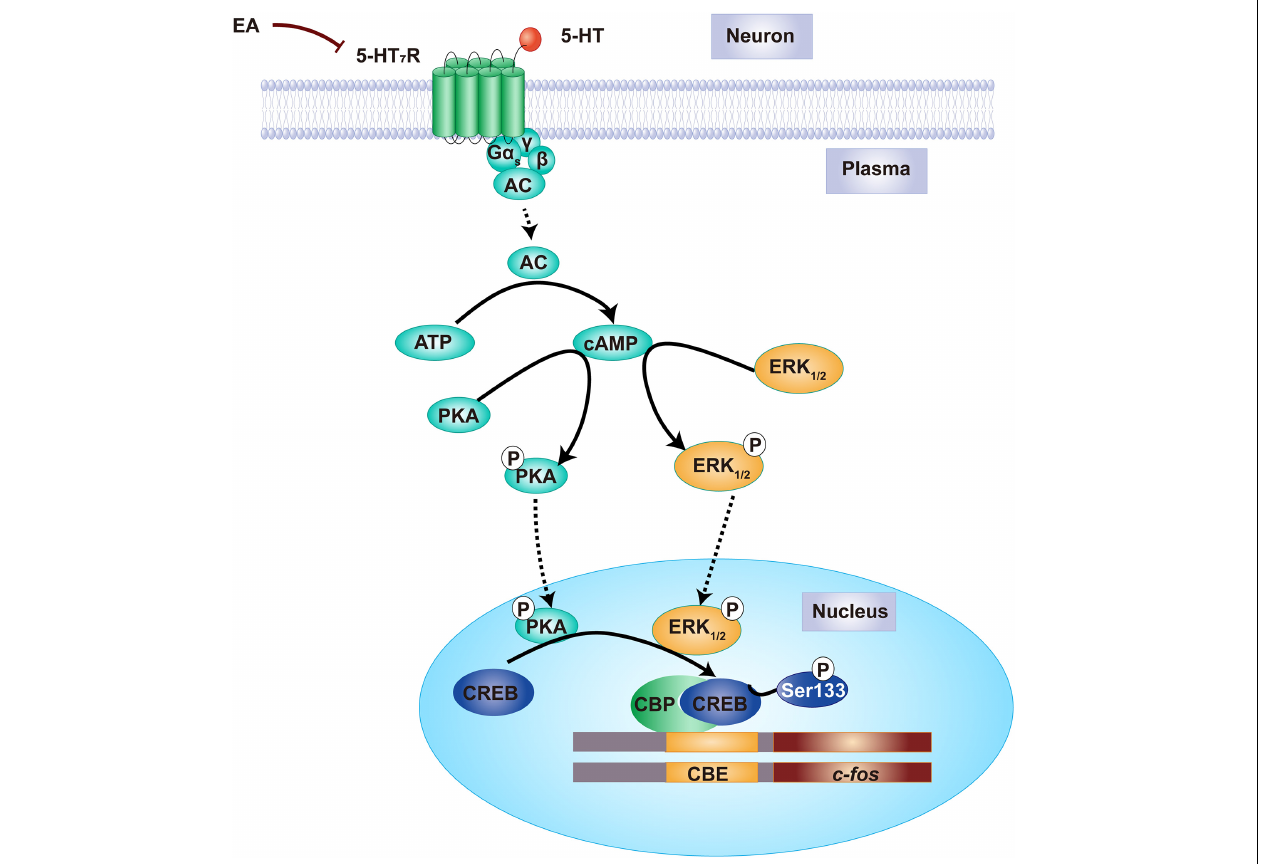
FIGURE 10 | Proposed mechanism of the antihyperalgesic effects of EA stimulation. Before EA, there is a relatively high amount of 5-HT 7 R protein in TG and TNC of IS rats. The medial cAMP is formulated in the cytoplasm of neuron, resulting in PKA and ERK 1 / 2 phosphorylation. Once PKA and ERK 1 / 2 are phosphorylated into p-PKA and p-ERK 1 / 2 , the CREB will move from the cytoplasm into the nuclear and phosphorylated at Ser133. Following nuclear CREB-CBP elevation, the initiate or potentiate of early gene c-fos was regulated by p-CREB-mediated transcription, resulting in dural IS stimulation that leads to hyperalgesia. By contrast, EA treatment decreases the amount of 5-HT 7 R proteins, forming lower cAMP, thereby PKA and ERK 1 / 2 phosphorylation is inhibited in the cytoplasm. This prevents CREB phosphorylation, and therefore gene c-fos silence, ultimately producing an antihyperalgesic effect. 5-HT 7 R, 5-hydroxytryptamine (5-HT) 7 receptor; cAMP,